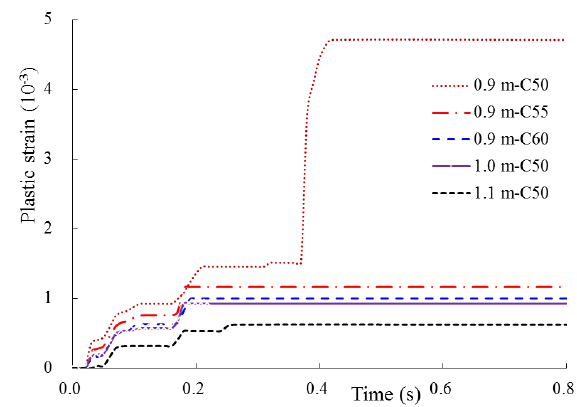
Figure 25. Max plastic strain time-history of concrete.